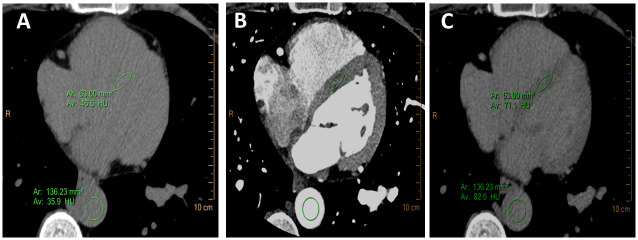
Representative example of extracellular volume (ECV) fraction measurement.Myocardial and blood pool attenuation values were measured at the mid segment of the septum and at the descending aorta; respectively, in the pre-contrast (A) and 7 minutes post-contrast (C) CT scan. The contrast scan (B) was used to localize the region of interest, which than could be replicated to the pre- and post-contrast scan. Attenuation values were than used to calculate ECV fraction.